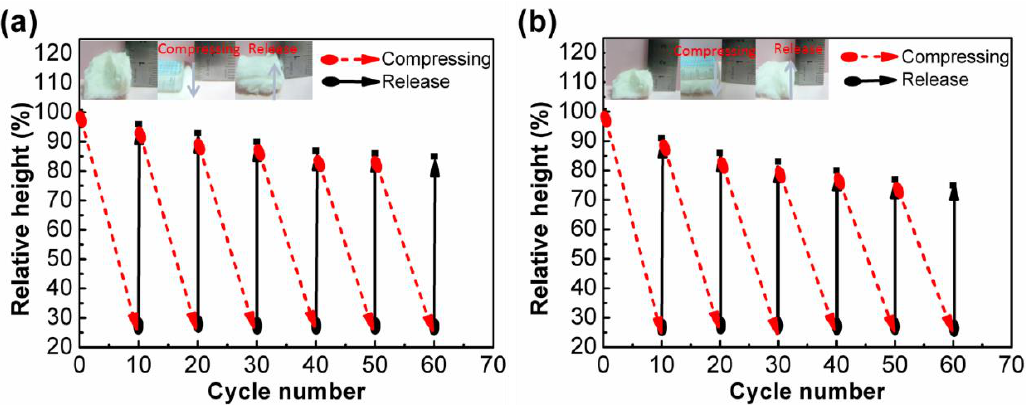
Figure 5. Height recovery of hydrophobic CF 3:2 ( a ) and CF 4:1 ( b ).